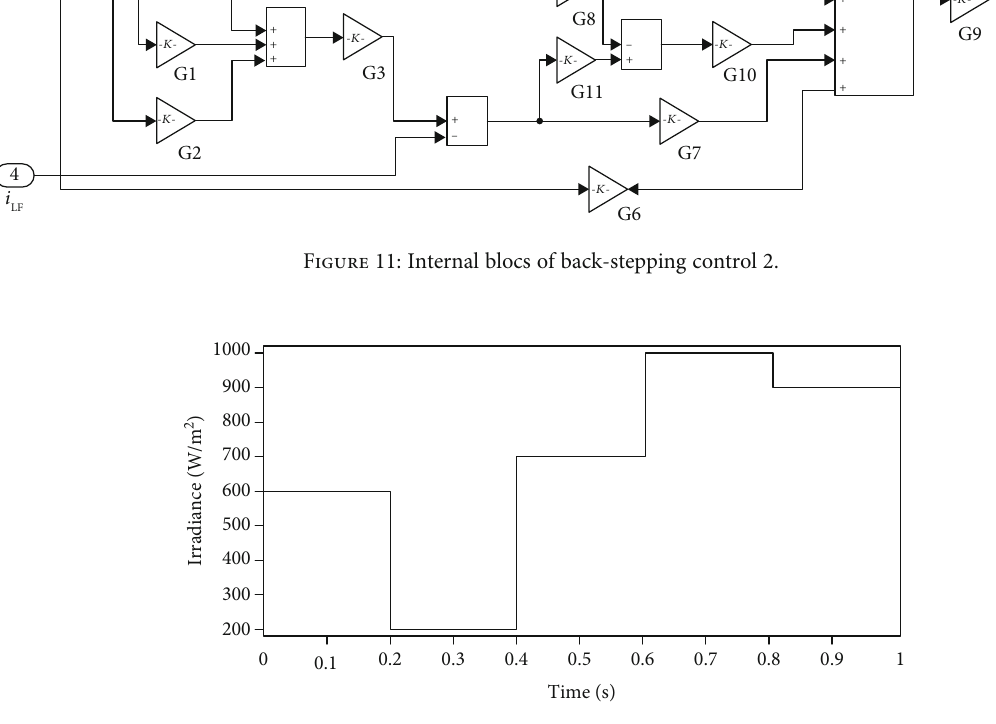
Figure 12: Sun irradiance pro fi